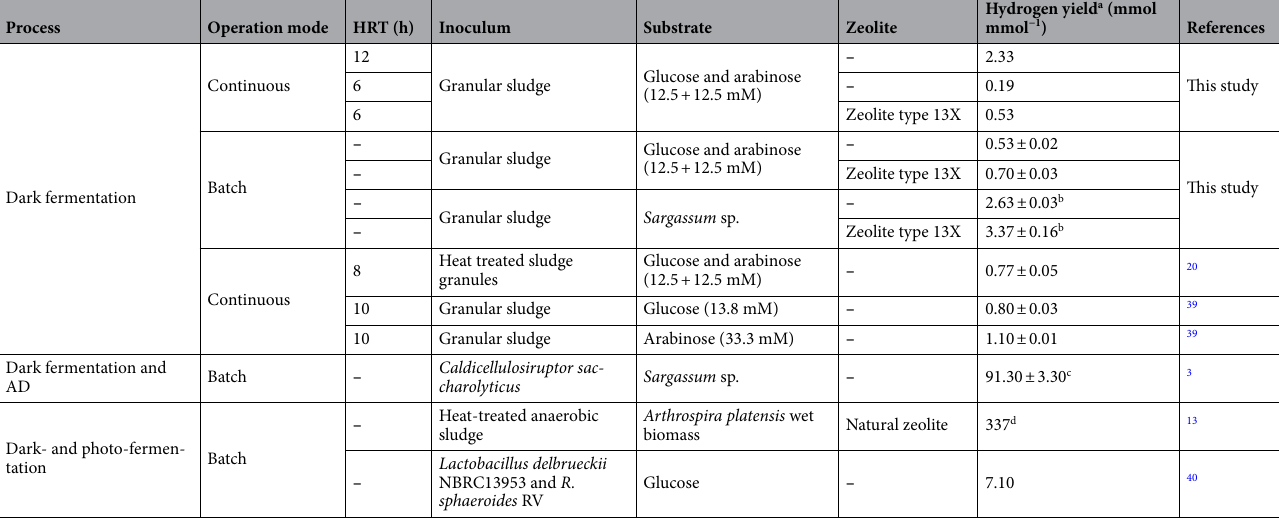
Table 6. Comparison of hydrogen yields obtained in this study in continuous and batch mode with the ones reported in literature. a mmole of H 2 per mmole of substrate. b H 2 produced per mass of Sargassum sp. (in VS) (mmol g −1 ). c Volume of H 2 produced per mass of Sargassum sp. (in VS) (L kg −1 ). d Volume of H 2 produced per mass of cellular dry weight (in VS) (L kg −1 ). e mmol of H 2 produced per bioreactor culture volume per hour of